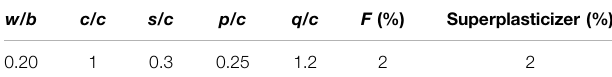
TABLE 6 | Optimum RPC mix proportion with steel fi ber.